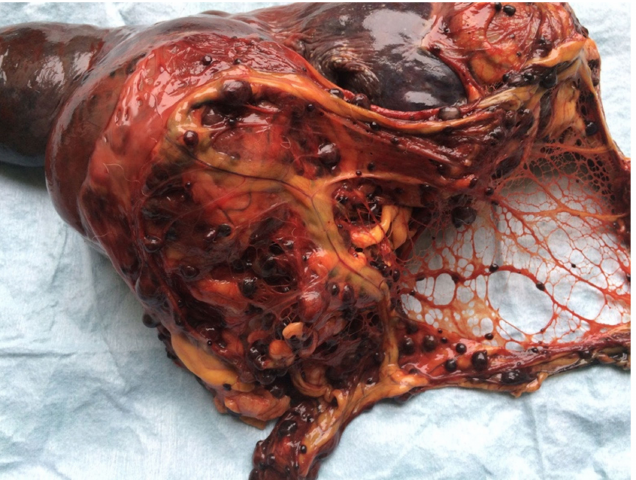
Figure 3. Female neutered crossbred, 13 years old. Splenic hemangiosarcoma, 15 cm in diameter, with multiple metastases on the